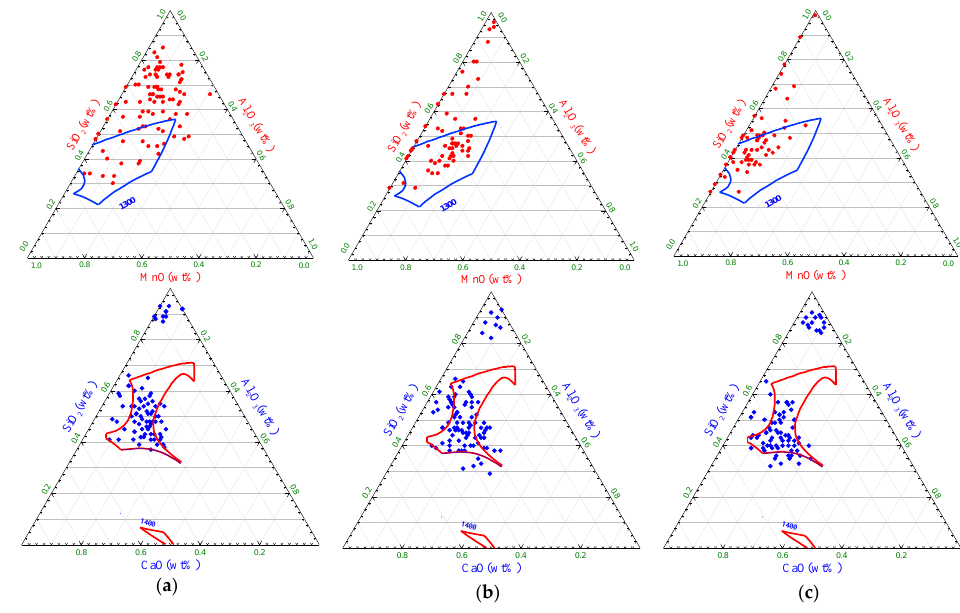
Figure 7. Inclusion distribution overlaid on phase diagram as a function of refining 2700 s (45 min) with the synthetic refining slags containing 2.5 – 7.5 weight percentage Rb 2 O ( a ) 2.5 wt% Rb 2 O; ( b ) 5 wt% Rb 2 O; ( c ) 7.5 wt% Rb 2 O.